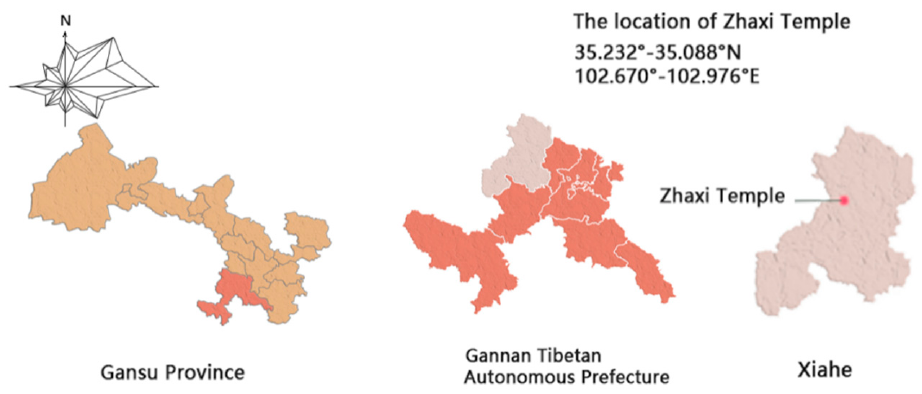
Figure 2. Location map (source: self-drawn).